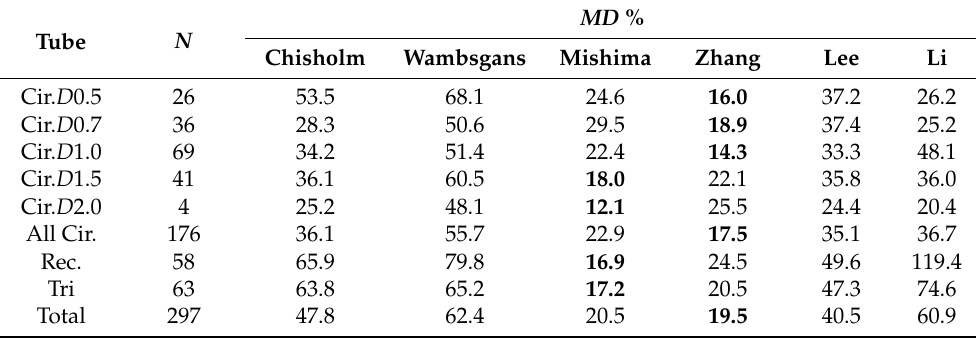
Table 3. Percentage mean deviation MD of each modified Chisholm parameter. (upward and downward